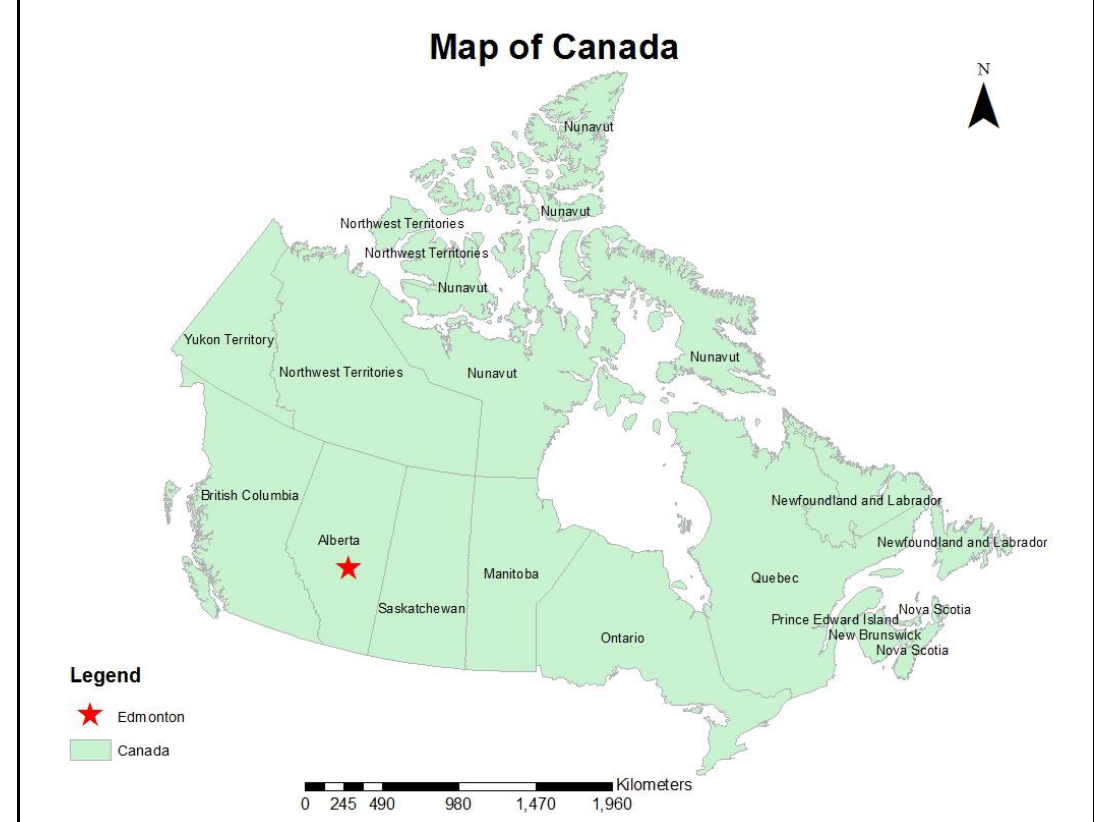
Figure 1. Map of Canada showing Edmonton.